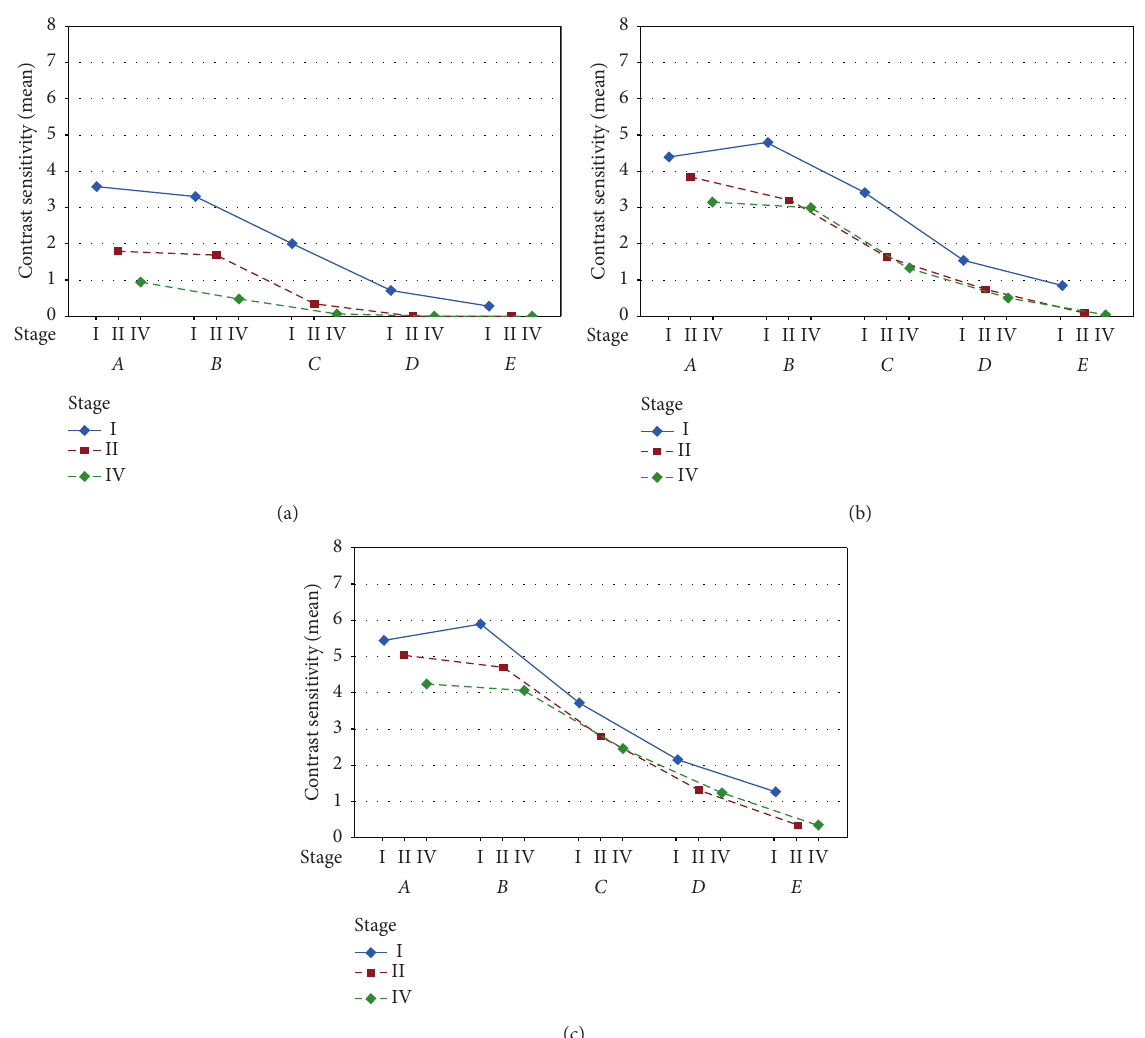
Figure 4: Mean preoperative and postoperative contrast sensitivity (CS) for all groups: (a) preoperative, (b) 1-month follow-up, and (c) 3- month